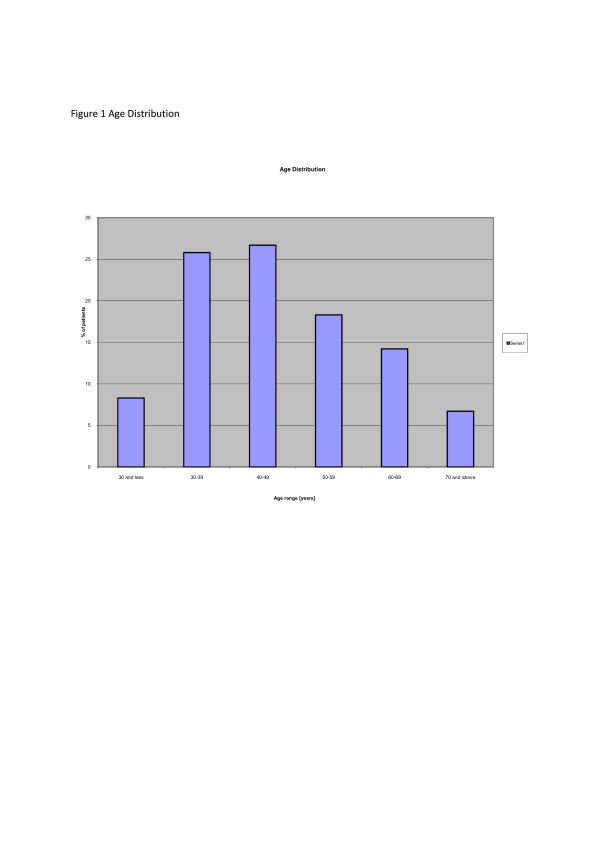
Age distribution.